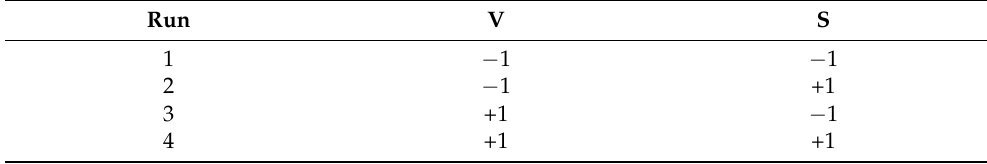
Table 5. Variables and experimental design levels for conducting experiments. Levels Used Factors Low ( − 1) High (+1) Velocity (m/s) 10 20 Sand Loading (mg/L) 300